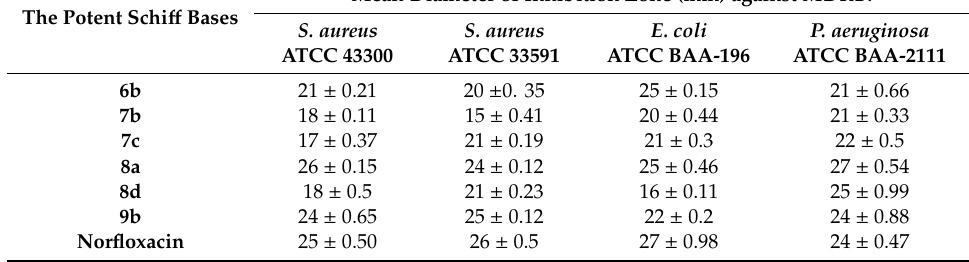
Table 6. In vitro antimicrobial activities of the most promising Schi ff bases against multidrug-resistant bacteria